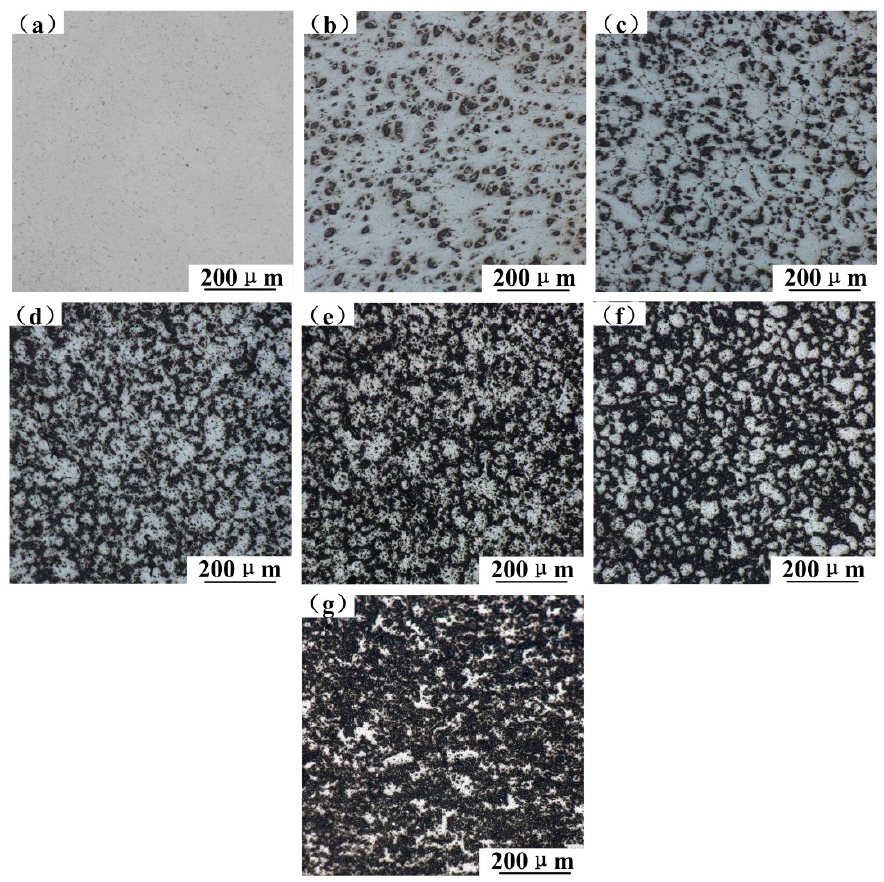
Figure 5. Optical micrographs of SiC p /6061Al composites: ( a ) 0%SiC/6061; ( b ) 5%SiC/6061; ( c ) 10%SiC/6061; ( d ) 15%SiC/6061; ( e ) 20%SiC/6061; ( f ) 25%SiC/6061; ( g ) 30%SiC/6061.